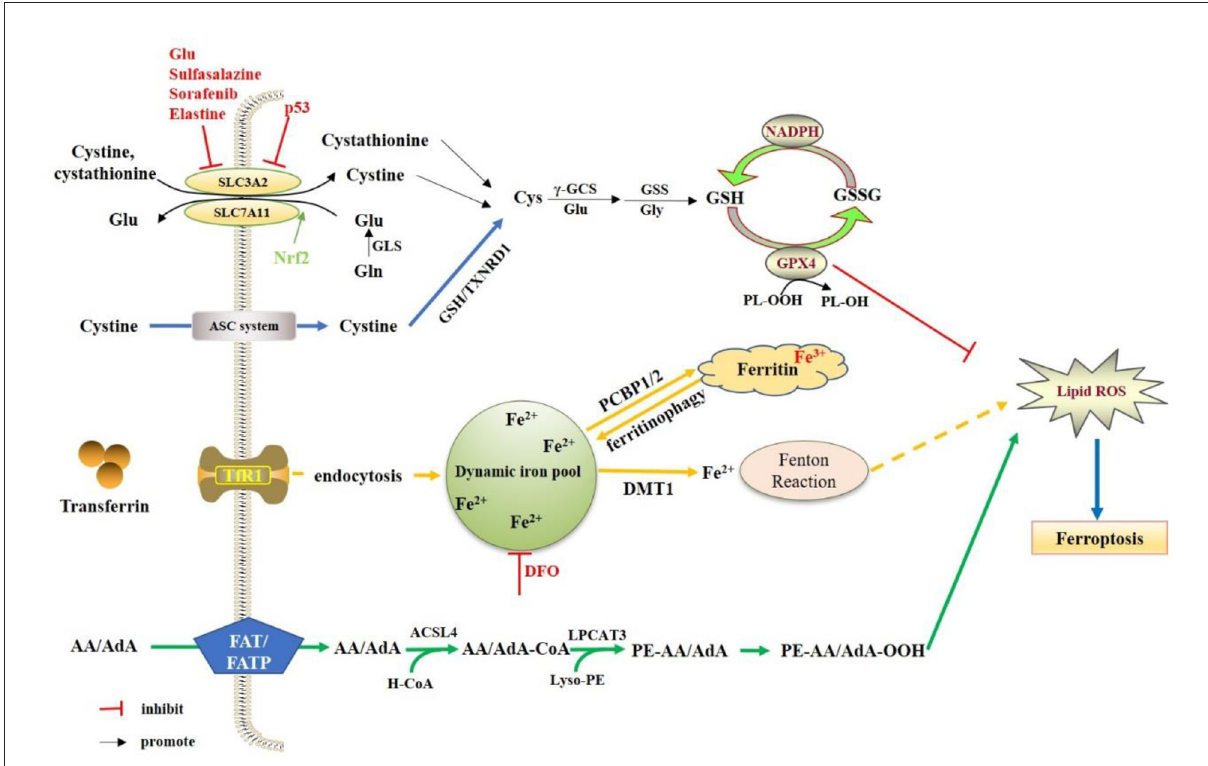
FIGURE1 Regulation mechanisms of ferroptosis. The System Xc- is a heterodimeric amino acid transporter composed of two subunits (SLC7A11and SLC3A2). Under oxidative conditions, System Xc-extracellular uptake of cystine to release glutamate. The cellular cystine will be reduced to cysteine. Cysteine is gradually produced by γ -GCS and GSS. The GSH molecules of GPX4 act as electron donor to reduce phospholipid hydrogen peroxide (PL-OOH) to the corresponding alcohol. NADPH can also reduce GSSG (oxidized GSH) to GSH by glutathione reductase. The extracellular iron will be mediated by transferrin and TfR1 into the cell. Then Fe3 + is reduced to Fe2 + , and Fe2 + will be transported to the dynamics iron pool, as well as stored in ferritin. In the presence of Fe2 + , hydrogen peroxide can generate hydroxyl radicals (OH–) through the fenton reaction, thereby promoting the oxidation of AA/AdA on the cell membrane. ACSL4 incorporates AA/AdA into the membrane as AA/AdA-CoA, and LPCAT3 inserts the acyl group into the lysophospholipid as PE-AA/AdA, of which will lead to the accumulation of PE-